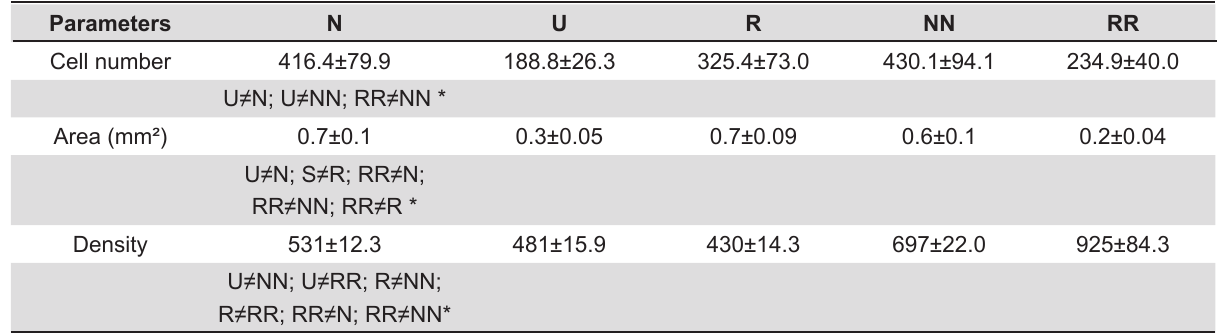
Figure 3- Scanning electron microscopy (SEM) of the mandible condylar process cartilage (CP) of Wistar rats of groups N, nourished from day 21 to day 60; U, undernourished from day 21 to day 60; R, renourished from day 21 to day 60; and NN, nourished until day 100. A - D: 500X; E - H: 700X; I - L: Table 1- Mean (±SD) cell numbers of chondroblastic layer, cartilage area and cell density of mandible condylar process cartilage (CP) of Wistar rats. SD=Standard Deviation